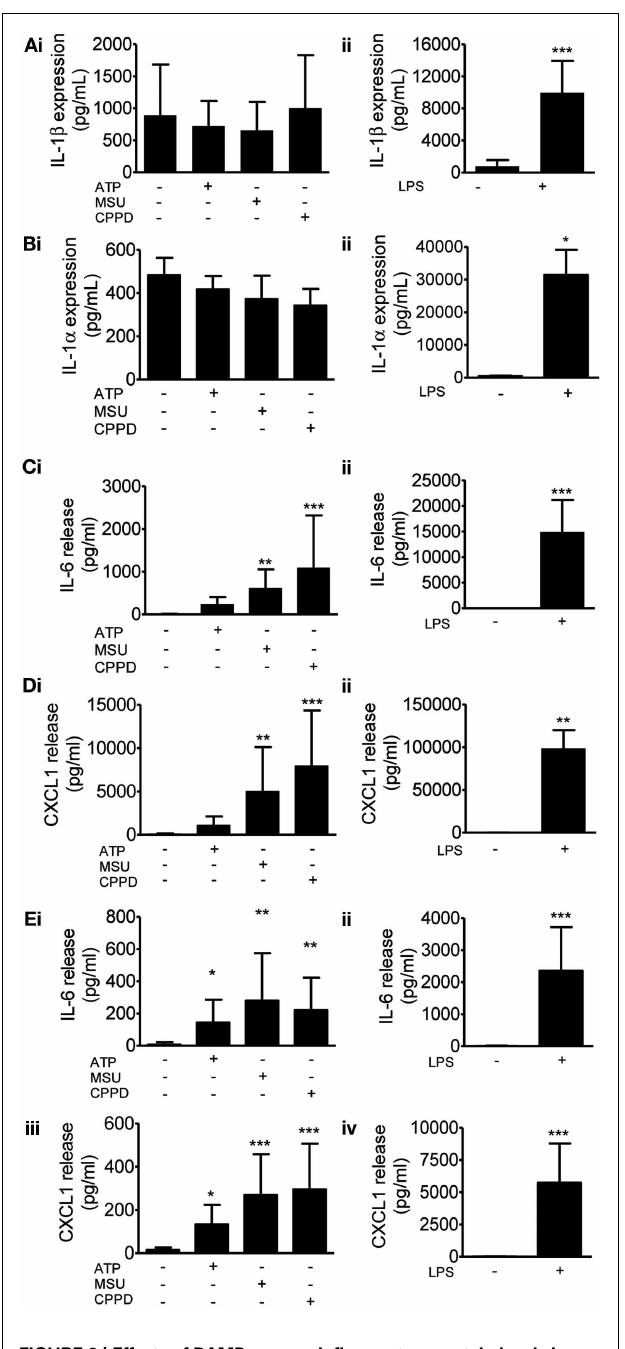
FIGURE 2 | Effects of DAMPs on pro-inflammatory protein levels in cultured mixed glia. Protein levels of pro-inflammatory mediators were measured by specific ELISAs after 24h (A–D) or 4h (E) exposure to the NLRP3-activating DAMPs ATP (5mM), MSU, and CPPD [both 250 µ g/ml; (Ai) ] or the PAMP LPS [1 µ g/ml; (Aii) ].The proteins analyzed were IL-1 β (A) , IL-1 α (B) , IL-6 (C,E) , CXCL1 (D,E) . Data are pooled samples from at least